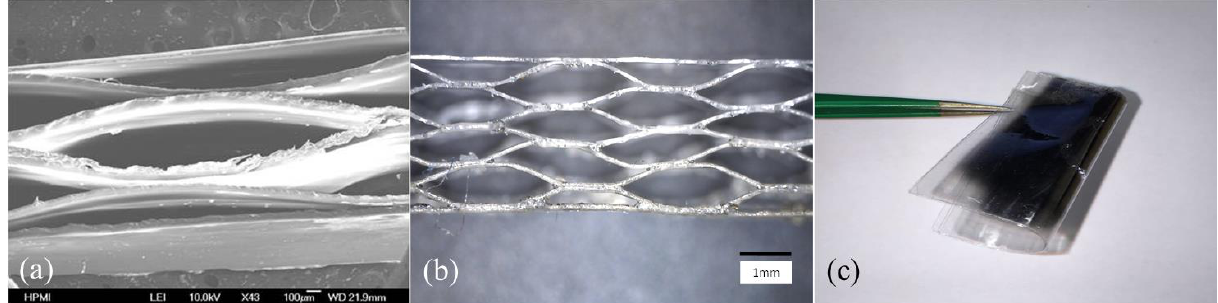
Figure 1. ( a , b ). SEM and optical microscope image of cross-section of the honeycomb structure ( c ). Photograph of prepared flexible COC piezoelectric sensor (4 layers of COC film).